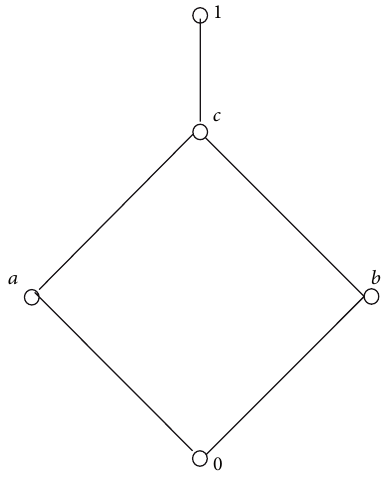
Figure 1: The lattice in Example